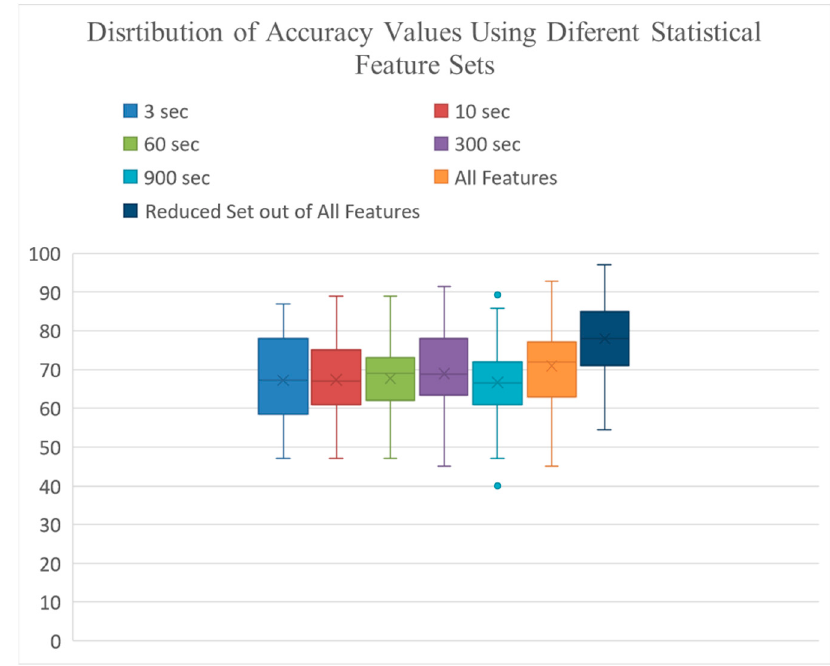
Figure 6. Distribution of accuracy values using various statistical feature